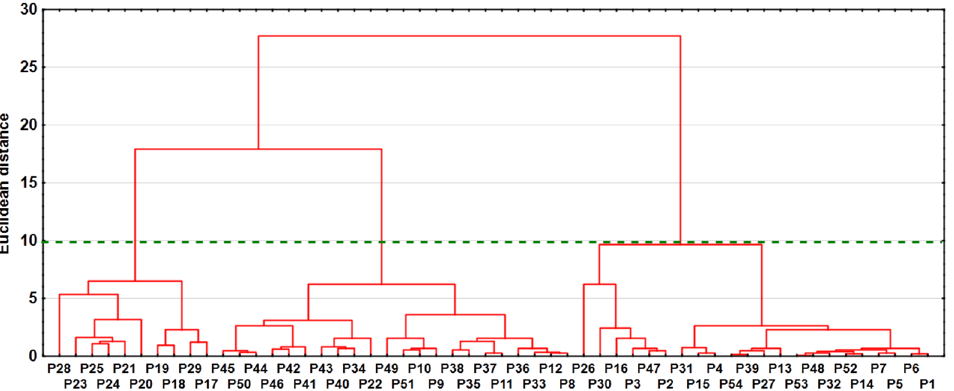
Figure 3. Clustering results via the Ward method for all parameters after standardization. The horizontal green dashed line indicates optimal number of clusters.